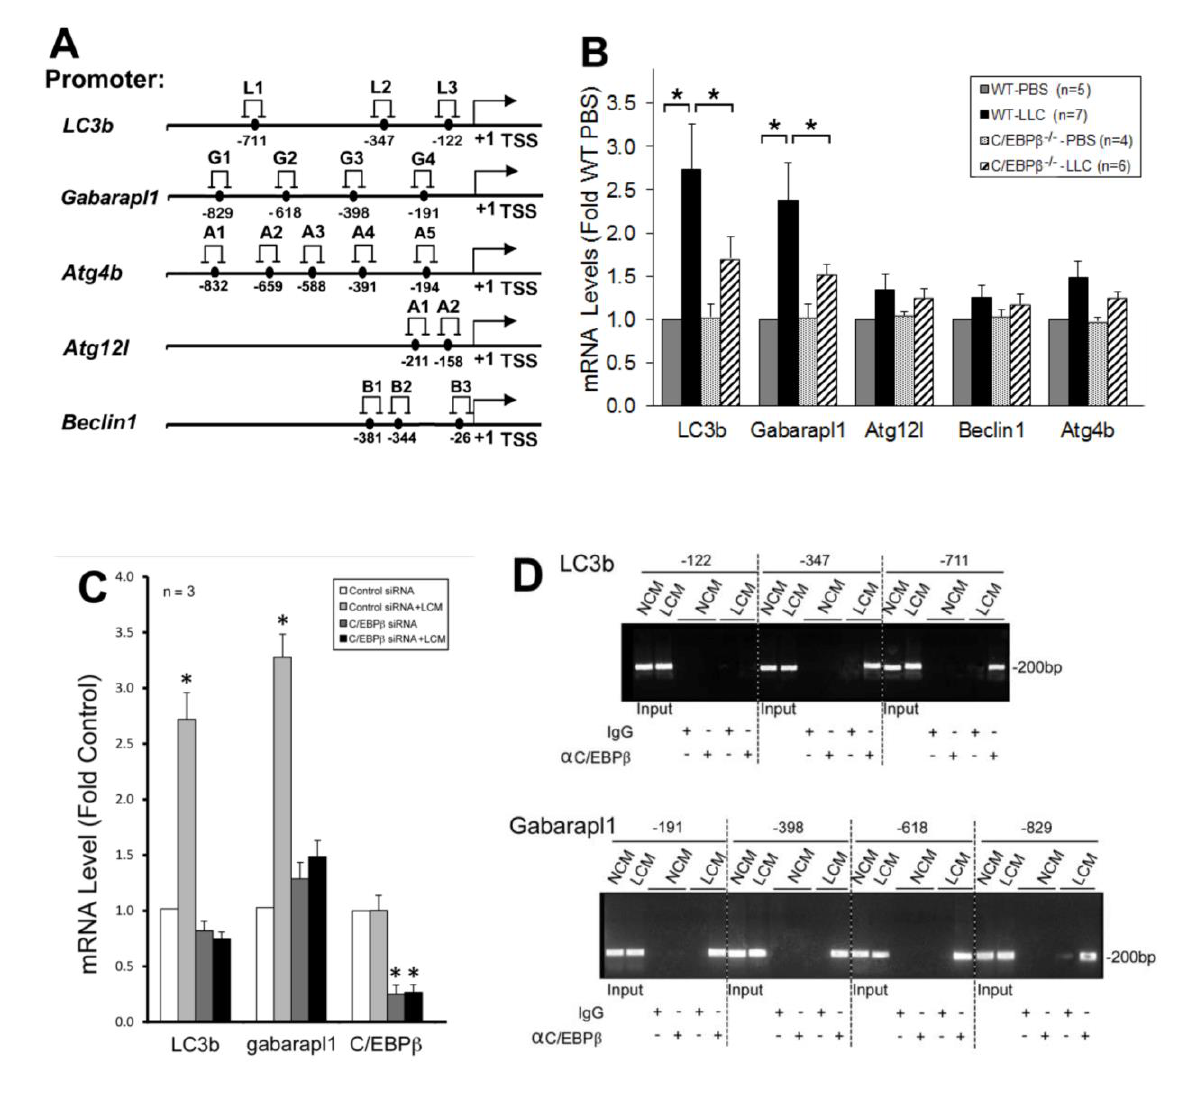
FIGURE 4. C/EBP  mediates tumor induction of autophagy-related genes in skeletal muscle cells. (A) Potential C/EBP  -binding cites are identified in autophagy-related genes. Data base search identified multiple potential biding sites of C/EBP  in the 5’ promoter region of listed autophagy-related genes. (B) LC3b and Gabarapl1 are upregulated in skeletal muscle of LLC tumor-bearing mice in a C/EBP  - dependent manner. Total RNA was extracted from the TA of wild type and C/EBP  knockout mice implanted with LLC cells for 21 days,